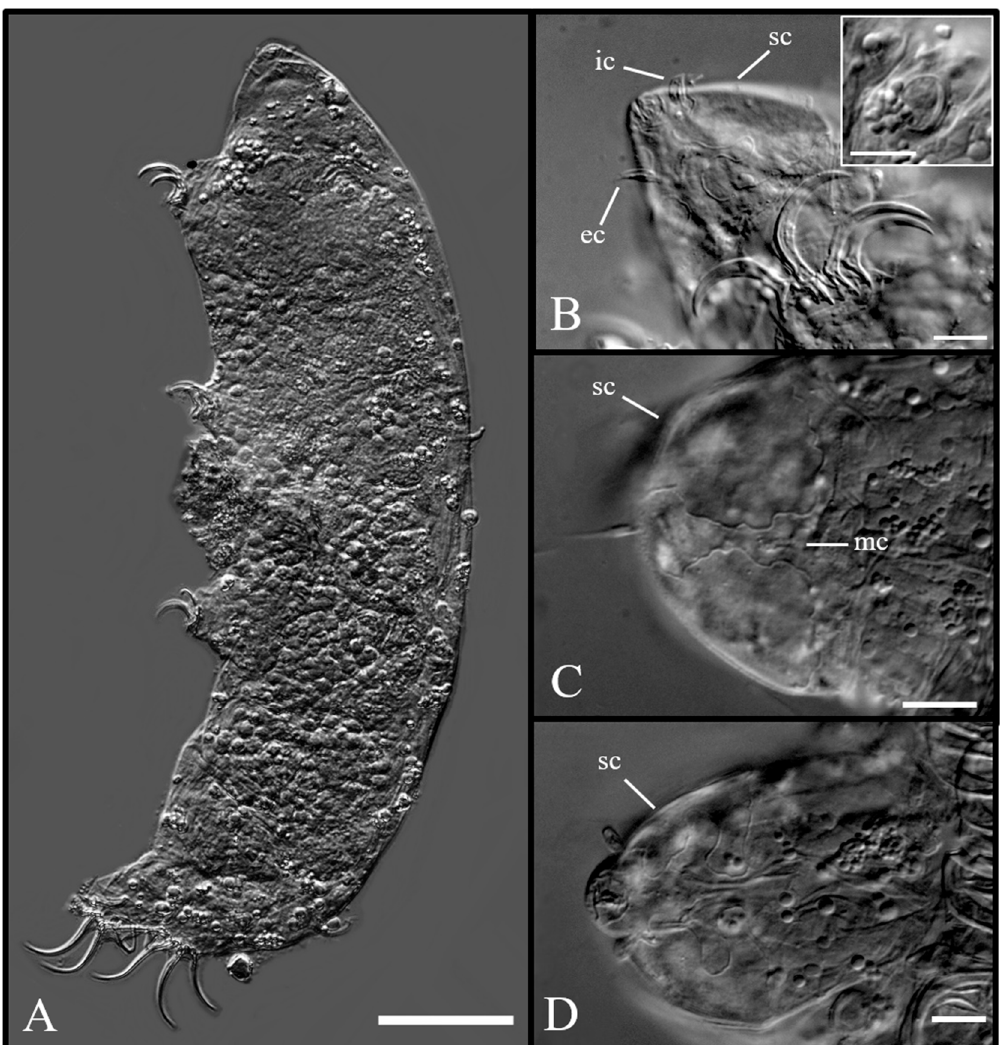
Figure 3. Coronarctus dissimilis sp. nov. (A) Habitus; (B) Ventral view of the head showing the cephalic cirri, secondary clavae, and claws on legs I. Insert with detail of the primary clava embedded into socket; (C) Posterior dorsal lobes of secondary clavae and median cirrus; (D) Ventral lobes of secondary clavae. Abbreviations: ec—external cirrus; ic—internal cirrus; mc—median cirrus; sc—secondary clava. Scale bars: 10 µm.